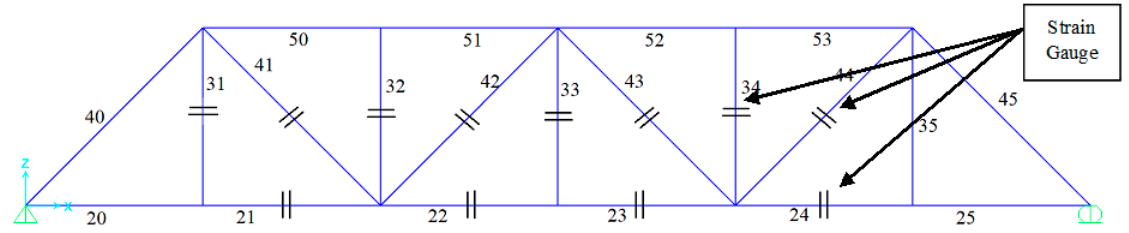
Figure 4. Truss elements with element numbering.